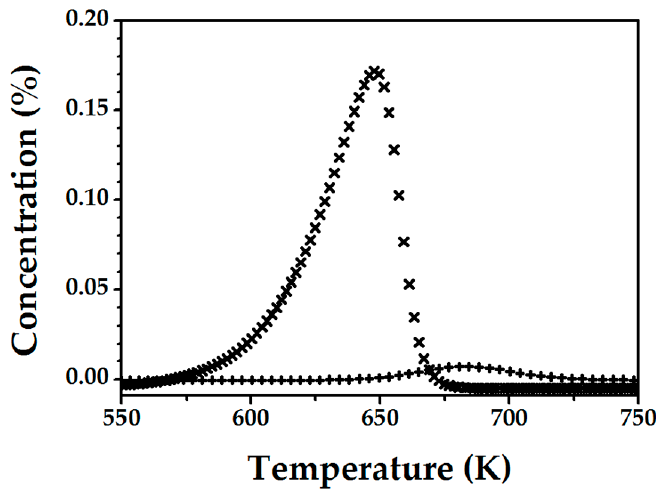
Figure 1. O 2 -( (cid:54) ) and NO- ( (cid:58) ) TPD profiles for FeZSM-5 2300Fe activated in He at 1273 K for 30 min, Figure 1. O 2 -(  ) and NO- (  ) TPD profiles for FeZSM-5 2300Fe activated in He at 1273 K for 30 min, after contact with N 2 O at 523 K for 5 after contact with N 2 O at 523 K for 5 min.